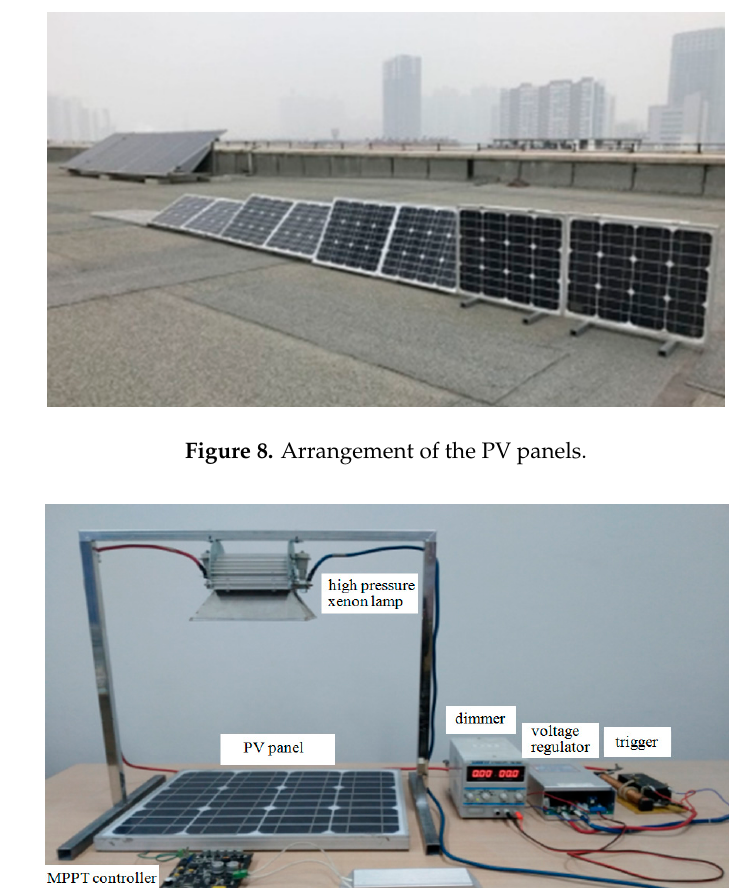
Figure 9. Structure of the special measurement system.